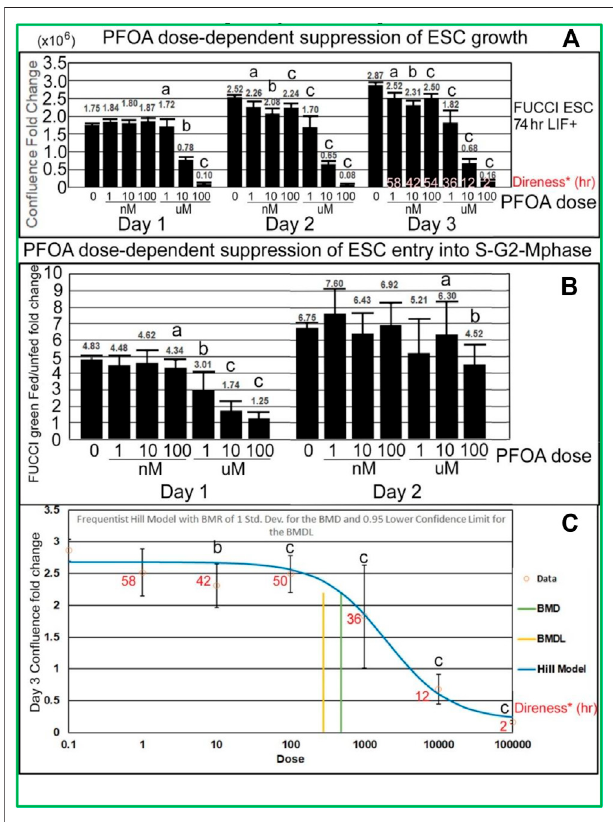
FIGURE 6 | PFOA decreases accumulated cell con fl uence for all three culture days, but instantaneous increase in fed/unfed entry into the S-G2-M- phase shown by green peak fl uorescence was more sensitive on day 1 than day2. (A) Con fl uencefoldchangefromtheindicatedtimetotimezerofor different doses of PFOA are shown (T26/T0, T52/T0, and T74/T0). As data of the con fl uences of the wells before the fi rst feeding of the toxicant are not known, T0 was used (2 h after the fi rst feeding) for NS. As the cells grow for a longer period, the effect of the doses increases, causing the LOEL to be a lowerdose.Thedirenesspointsofdeparturefrom Figure5A areshowninthe day 3 bars. (B) The amount of green fl uorescence at the peak after feeding and the nadir before feeding is rationated. In general, the green fold change decreases as the dose of PFOA increases. (C) Day 3 con fl uence FC from A was analyzed, using the Benchmark dose as point of departure. Direness points of departure are shown in Figure 5A . For PFOA, we chose the frequentist Hill v1.1 model because it has the lowest AIC and the highest p -value (though still < 0.1). All the models were deemed questionable. For the Hill model, constant variance test failed (test two p -value < 0.05) NS (0 dose): N is described in Figure 1 . PFOA: four biological experiments. N (cid:1) 8 for each dose except 100 uM where N (cid:1) 6 for day 3 con fl uence fold change in Panel 6A,allofPanel6BandPanel6C.(a)aretheNOAEL,(b)aretheLOAEL,and(c) are signi fi cantly different from the 0 dose but not the LOAEL. Fig.6A: (b) have p < 0.0001 for day 1 and p < 0.001 for days 2 and 3; (c) have p value ranging from < 0.005 to < 0.0001. Fig.6B: (b) have p < 0.05, (c) have p ranging from < 0.05 to < 0.0001. Panel 6C: BMD (cid:1) 483.8nM, BMDL (cid:1) 278.3 nM. case of PFOA, the LOAEL dose for cell accumulation decreases from 10uM to 10 nM with time progression from one to three days. As more cells accumulate in the NS/zero dose exposure, the accumulative stress exposure is detected at lower doses. The stimulation index of FC suppression of accumulation comparing 100uM PFOA and 0uM/NS (that is, the comparison